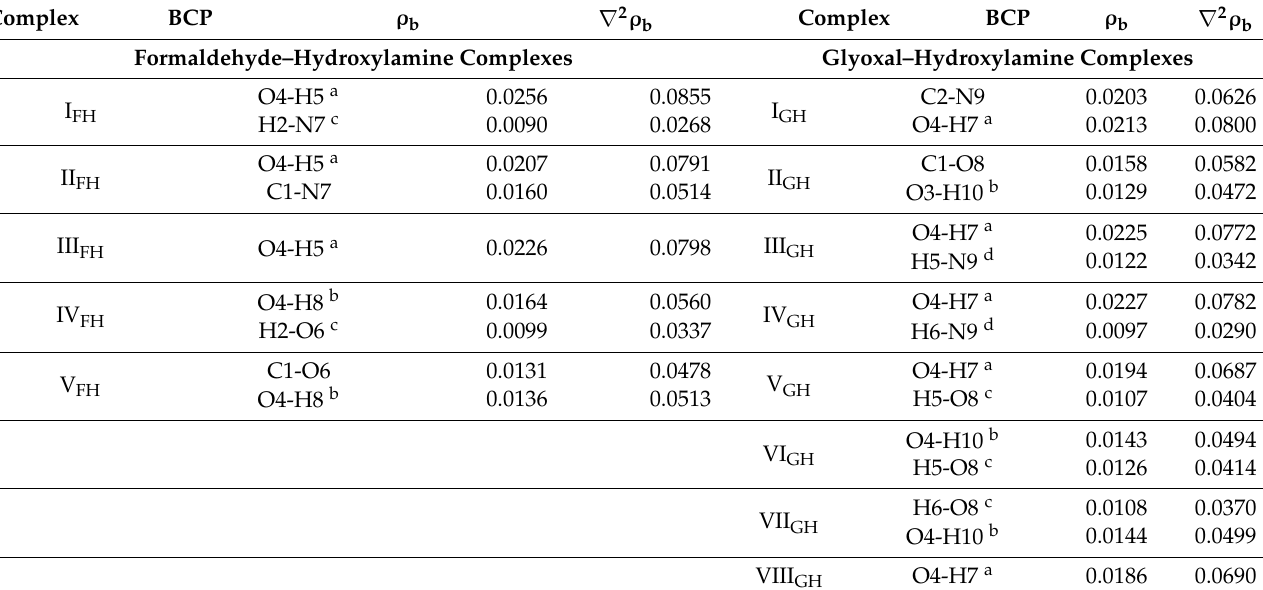
Table 4. AIM properties of selected critical points computed at the MP2/6-311++G(2d,2p) level. All data reported in atomic